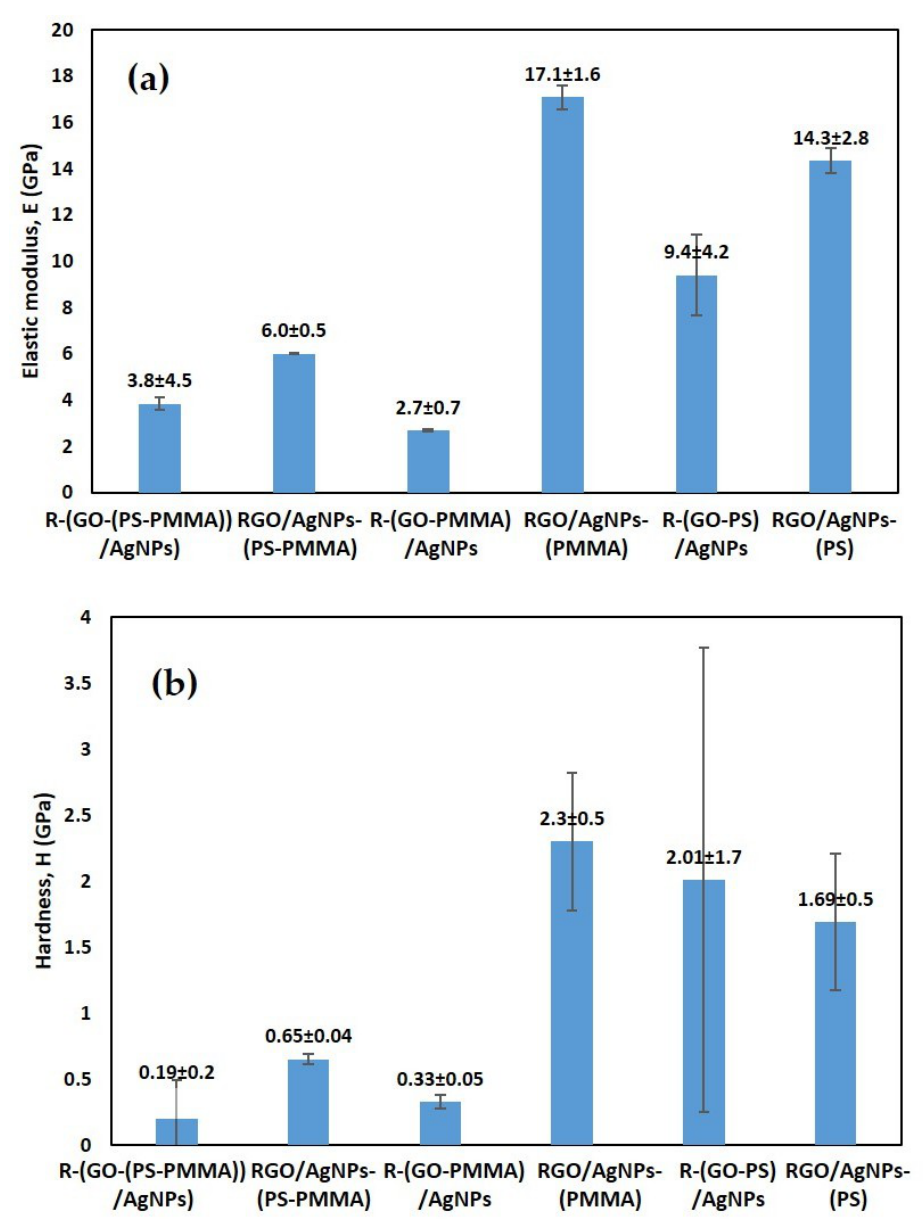
Figure 9. Berkovich nanoindentation: ( a ) elastic modulus and ( b ) hardness.